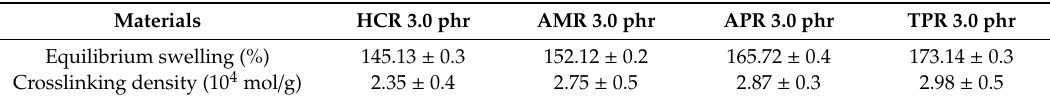
Table 2. Swelling and cross-linking density characteristics of rubber composites with varying content fractions of di ff erent resins.